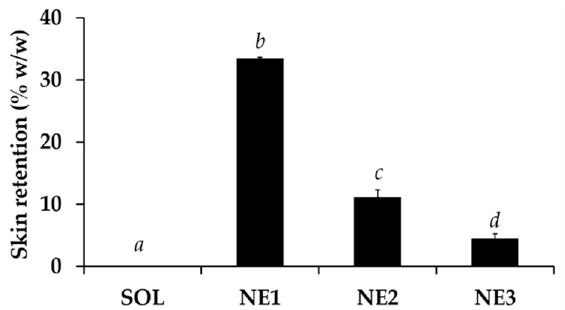
Figure 16. Skin retention of C. militaris extract (CW) from solution (SOL) and nanoemulsions containing various content of Tween ® 85, including 5% w/w (NE1), 10% w/w (NE2), and 15% w/w (NE3). The letters a, b, c, and d denoted significant difference between different formulations analyzed using one-way ANOVA with post-hoc Tukey test ( p < 0.05).